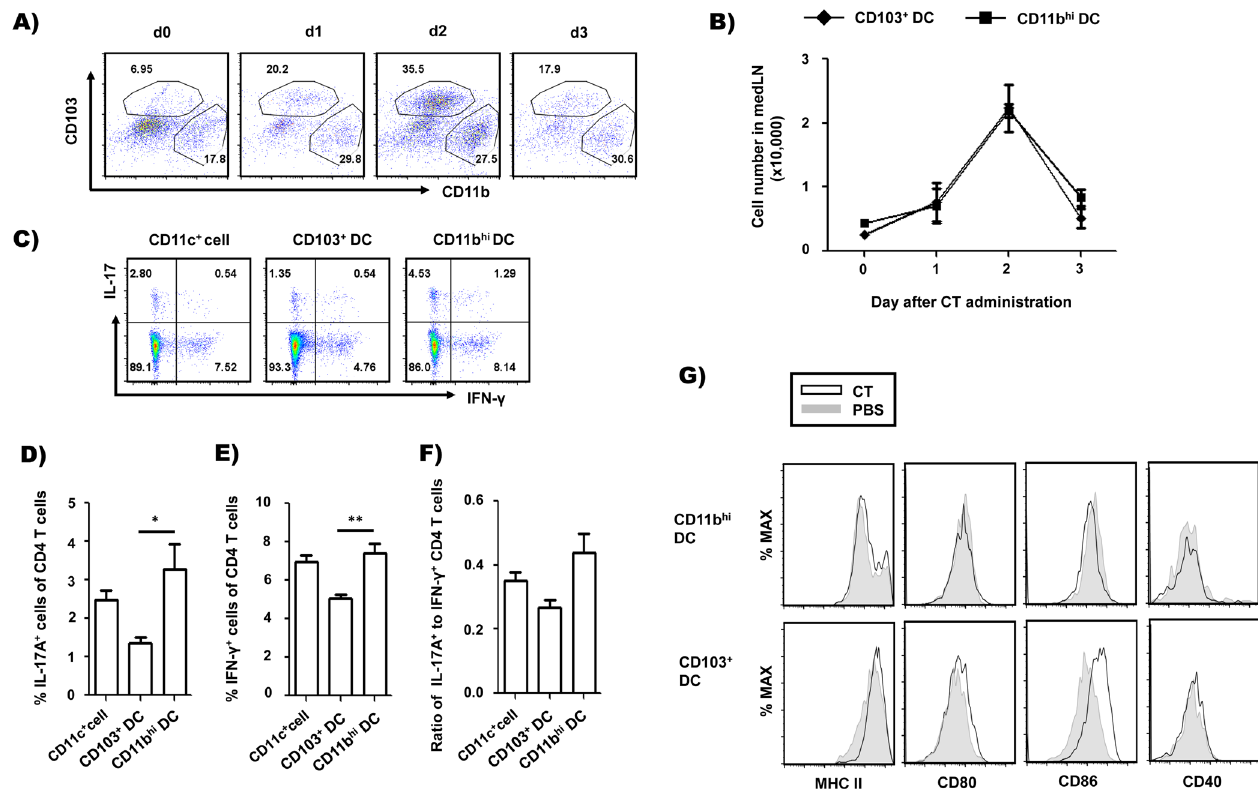
Fig 1. CD11b hi DCs and CD103 + DCs migrated to the lung draining lymph node after CT administration and CD11b hi DCs with the MHCII lo CD86 lo phenotype mediated IL-17-favored differentiation of CD4 T cell. Mice were intranasally administered 2 μ g CT, and mediastinal lymph node (medLN) cells were prepared from the mice at day 1, day 2, or day 3 after or before CT administration. (A) Flow cytometry analysis of migratory DC subsets after CT administration. Five mice per group; migratory DC subsets in medLN (CD103 + DC and CD11b hi DC); (B) Cell number of each DC subset after CT administration; (C-F) CD103 + DCs and CD11b hi DCs were isolated from medLN cells of mice 2 day after intranasal CT administration, pulsed with 0.1 μ M of OVA 323-339 peptide and washed and cultured with OT-II CD4 + T cells for 5 days. Stimulated OT-II CD4 + T cells were analyzed for expression of IL-17A and IFN- γ by flow cytometry after restimulation with PMA and ionomycin. (C) Flow cytometry analysis and (D and E) frequency of IL-17A- and IFN- γ -expressing CD4 + T cells. (F) Ratio of IL-17A + to IFN- γ + CD4 + T cells. (G) MHC class II and costimulatory molecules on DC subsets isolated from medLN of mice 2 day after administration of CT or PBS. * p < 0.05, ** p < 0.01 (Student ’ s t -test). Data are from one experiment representative of two independent experiments with similar results. Dot plots and histograms are representative of four mice in A and G and quadruplicate wells in C and data are average ± SEM.